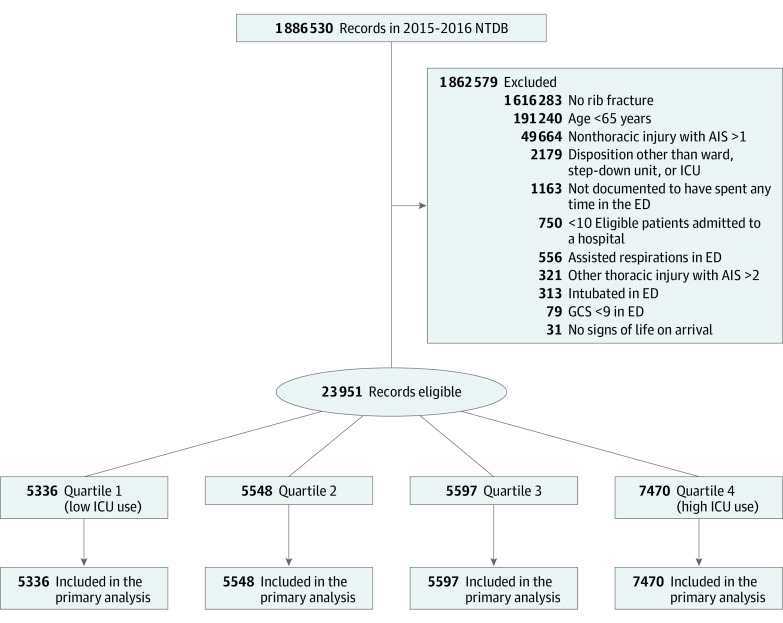
Derivation of the Study CohortAIS indicates Abbreviated Injury Scale; ED, emergency department; GCS, Glasgow Coma Scale; ICU, intensive care unit; and NTDB, National Trauma Data Bank.